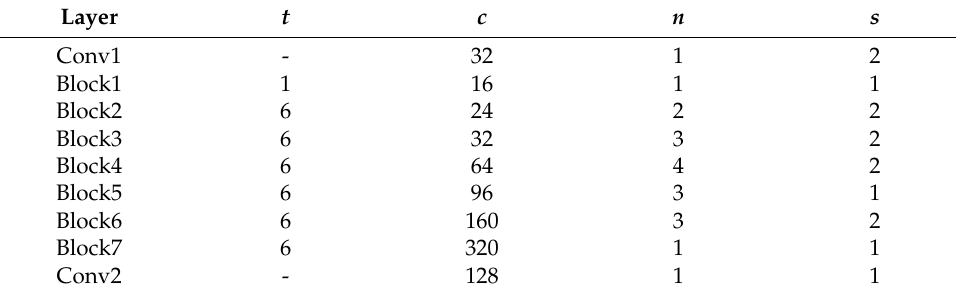
Table 2. Structure of feature extraction network.